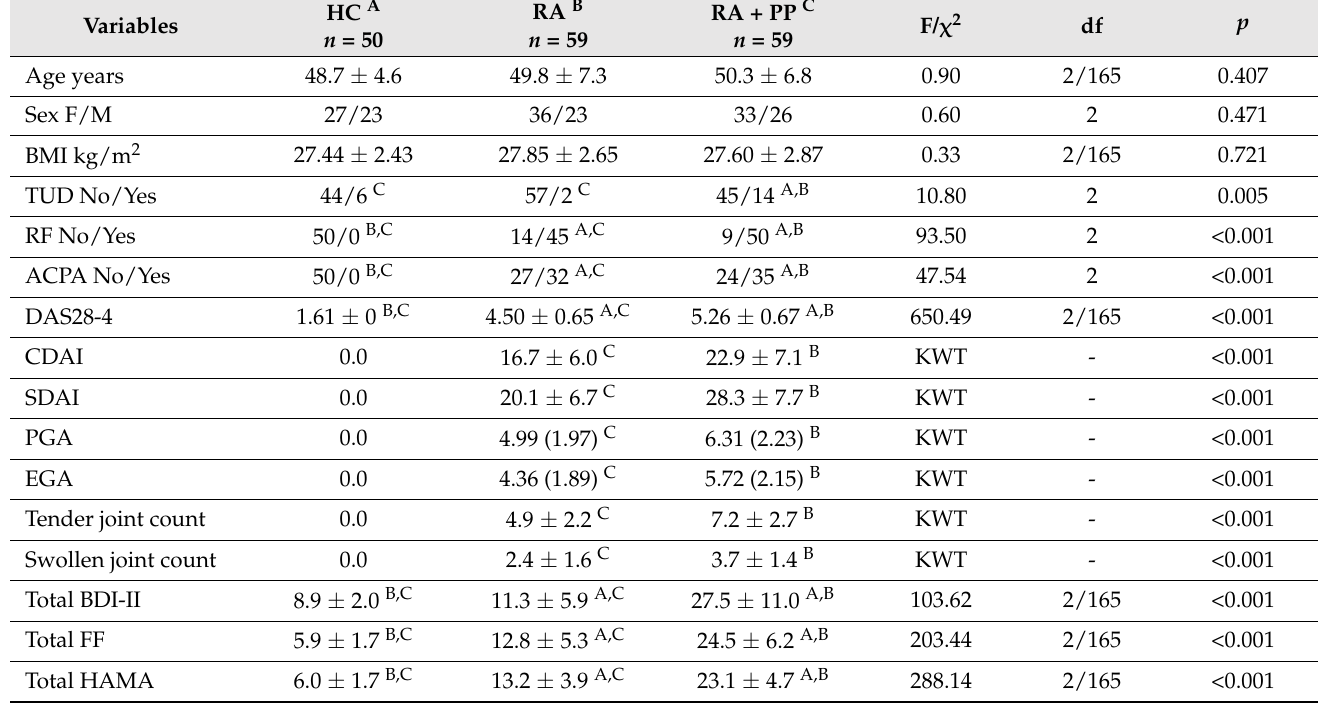
Table 1. Sociodemographic and clinical data in healthy controls (HC) and patients with rheumatoid arthritis divided into those with (RA + PP) and without (RA) increased psychopathology